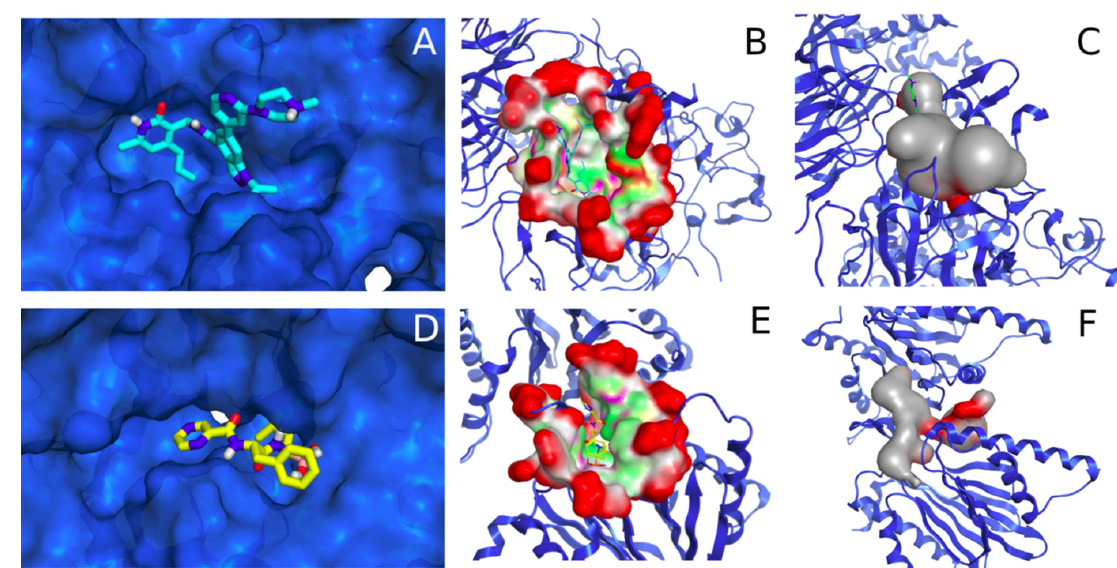
Figure 6. Binding pockets in EZH2 and P20S, respectively. The top row refers to EZH2’s pocket while the bottom row